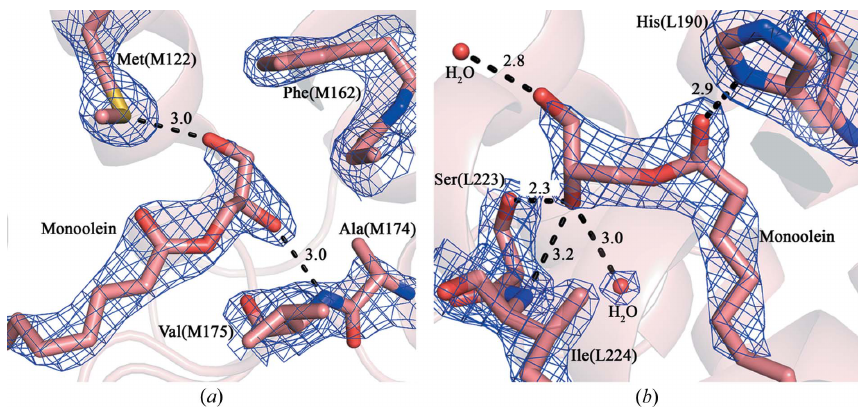
Figure 5 Monoolein molecules fitted into an electron density of interest in the Rba. sphaeroides RC (2.1 A˚ resolution, 1.6 (cid:2) ). ( a ) Carotenoid binding site and ( b ) Q B binding site.